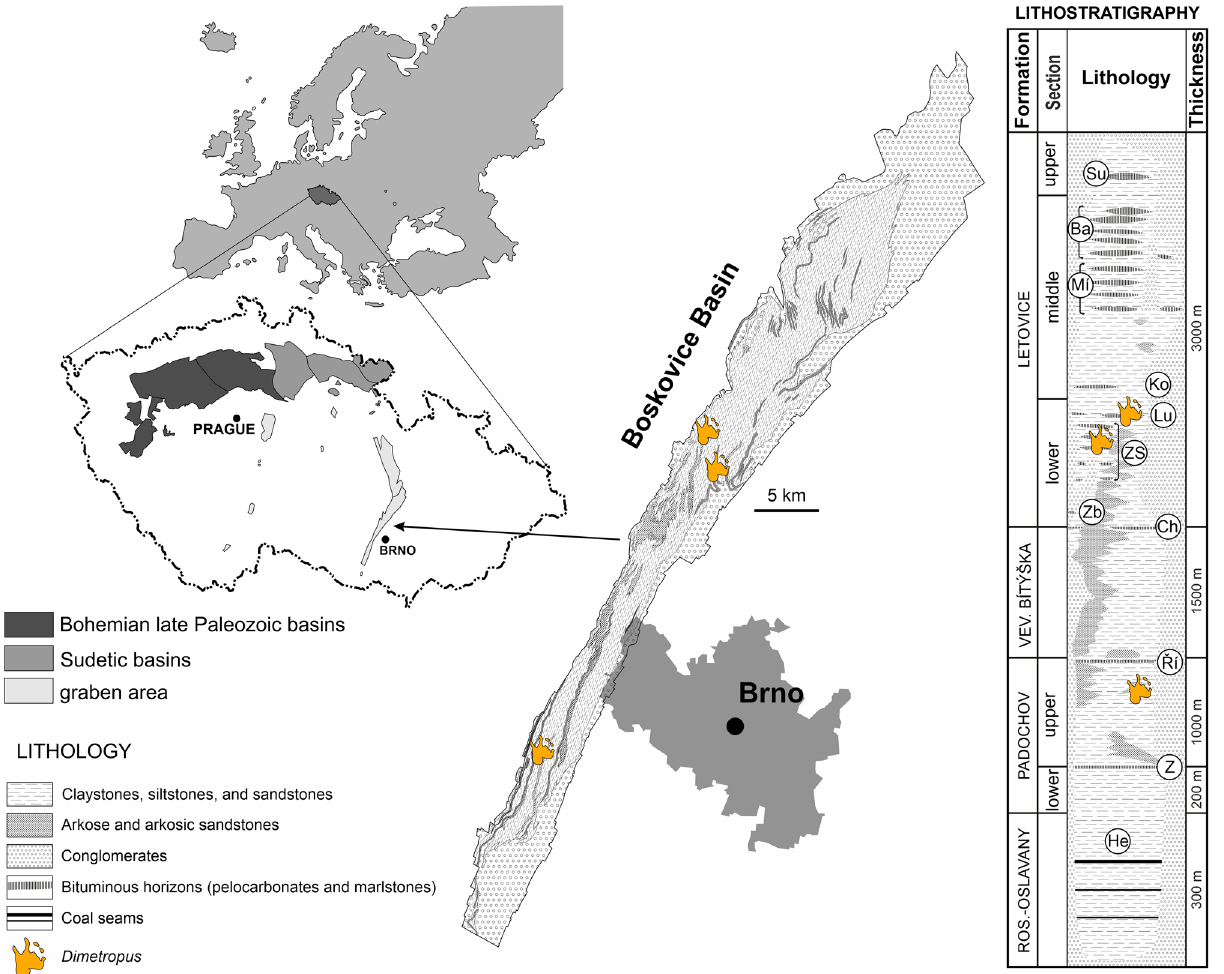
Figure 1. Location of the studied area and the distribution of Dimetropus tracks in the Boskovice Basin. Horizons: He Helmhacker, Z Zbýšov, Ří Říčany, Ch Chudčice, Zb Zbraslavec, ZS Zboněk-Svitávka, Lu Lubě, Ko Kochov, Mí Míchov, Ba Bačov, Su Sudice. Modified after 5 . The geological map and lithostratigraphy follow 14,28,29 . Chronostratigraphy follows 45 and Jirásek (pers.